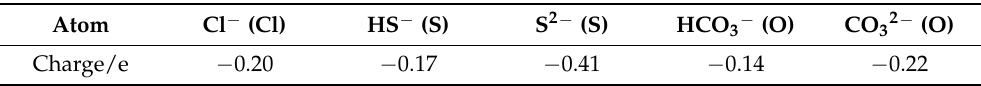
Table 3. Charge number of atoms with a negative charge in each corrosive species. Atom Cl − (Cl) Charge/e −